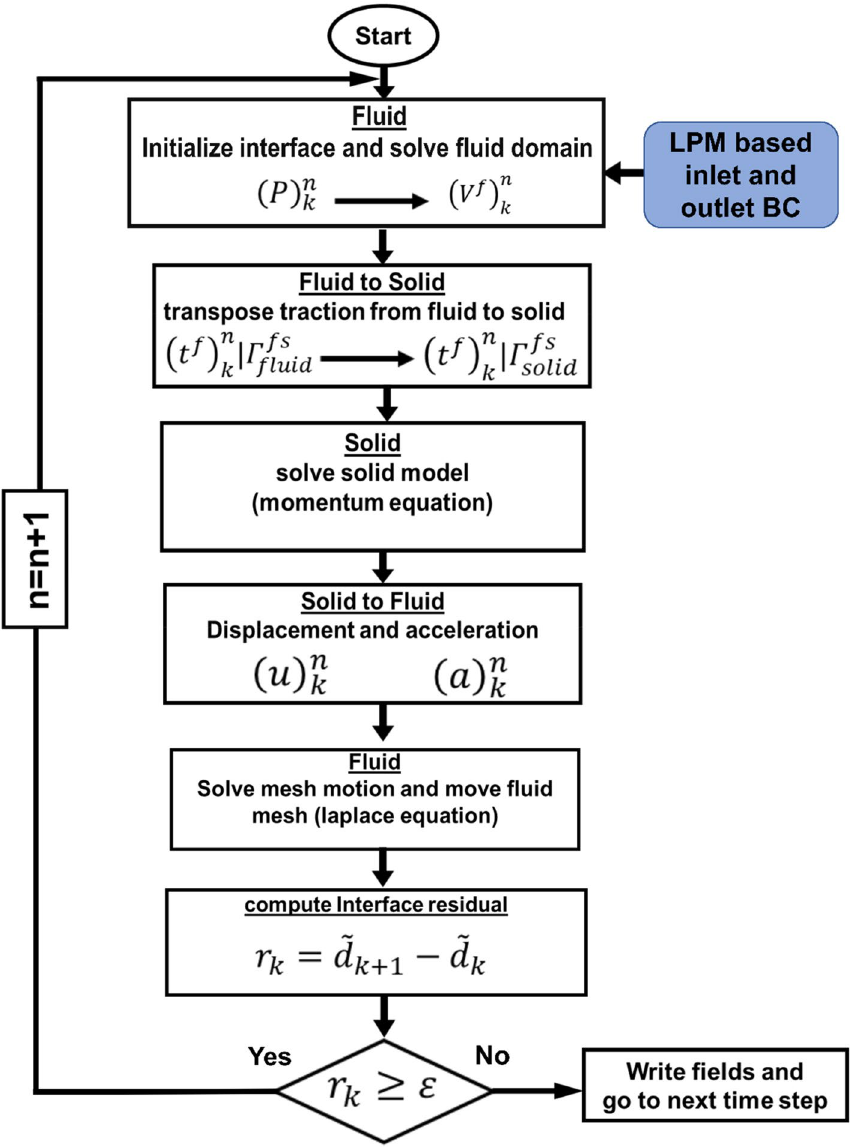
Figure 5. Patient-specific lumped parameter boundary conditions (BC) and strongly coupled FSI model flow